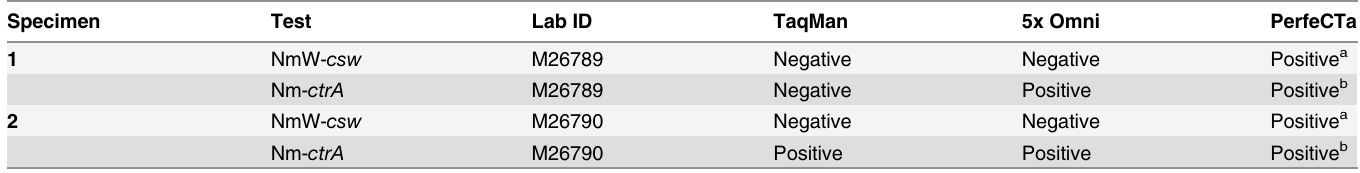
S1 Table. Primers and probes used for rt-PCR assays. S2 Table. Reaction assembly for traditional and two direct real-time PCR methods. S3 Table. Cycling conditions for the traditional and two direct real-time PCR methods. S4 Table. Panel of 25 species representing 14 different genera of bacterial isolates used for cross-reactivity